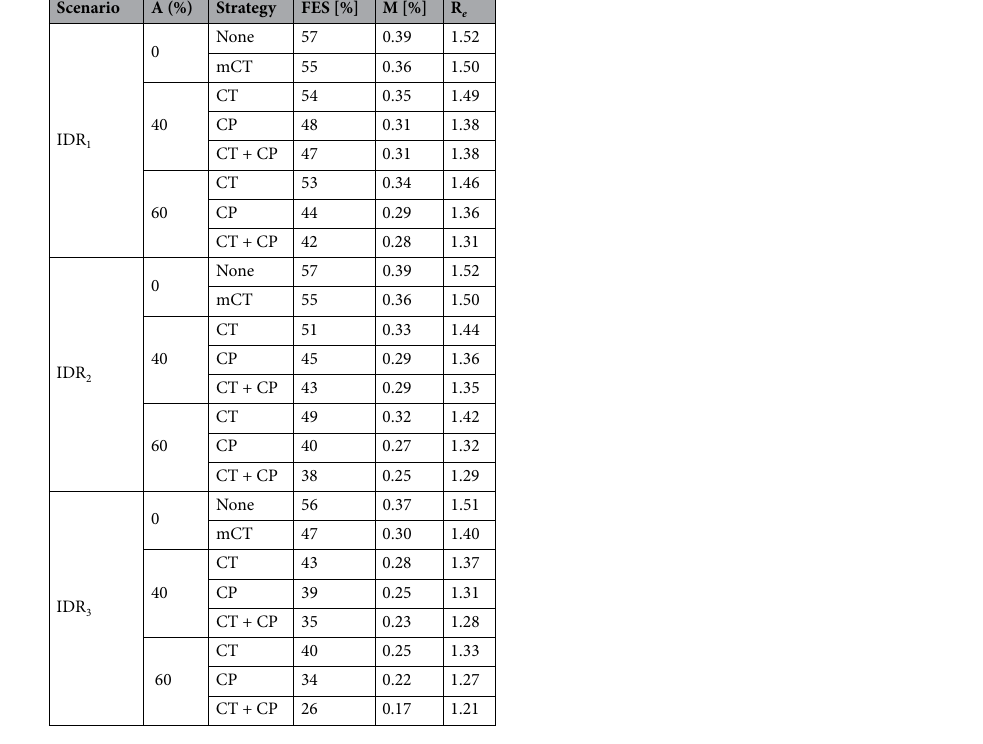
Table 1. Final epidemic size (FES), mortality rate (M) and effective basic reproductive number (R e ) for three IDR scenarios (average IDR values are given in brackets). Values for different transmission mitigation strategies and different app adoption rates (A) are compared. FES and mortality rates are calculated at the end of each simulation, while R e values are estimated as averages for days 20 to 25 of each